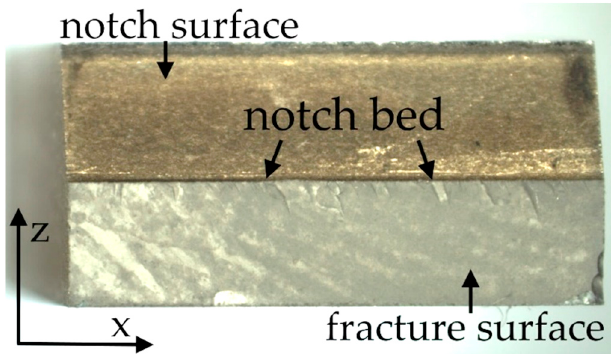
Figure 6. A real photo taken after the break of SM25T specimen.